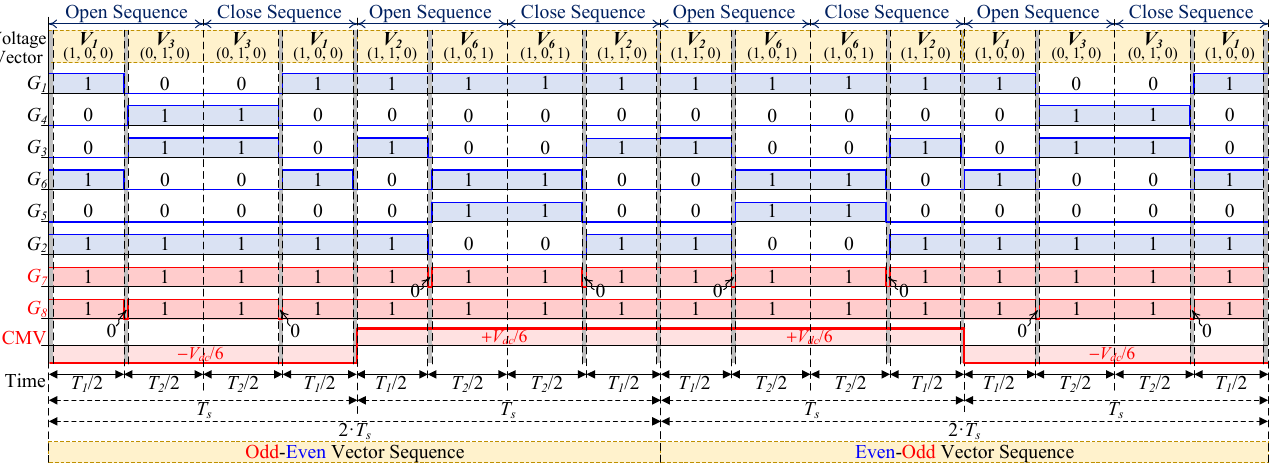
Figure 11. Modulation sequences of proposed method in vs. area of sector 1.